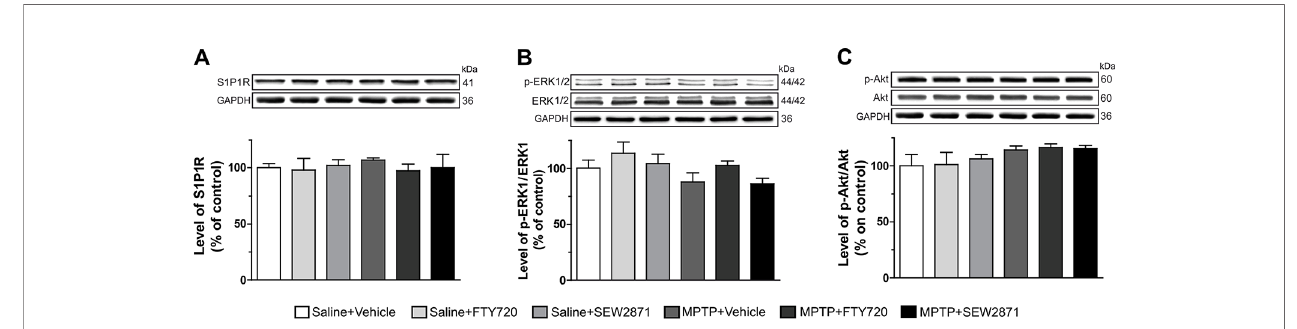
FIGURE 3 | Levels of neuronal activity markers were unaltered in the striatum. Protein levels were evaluated by Western blotting with proteins extracted (30 – 40 m g of protein) from the mouse striatum. Levels of S1P1R (A) , phospho-Thr202-ERK1 (B) , and phospho-Thr308-Akt (C) were determined. GAPDH was used as loading control. Data represent the mean of relative optical density in triplicate experiments of S1P1R, phospho-Thr202-ERK1 and phospho-Thr308-Akt (expressed as a percentage of control values) ± S.E.M. Values are respectively expressed relative to GAPDH, total ERK, and total Akt, n = 3 –